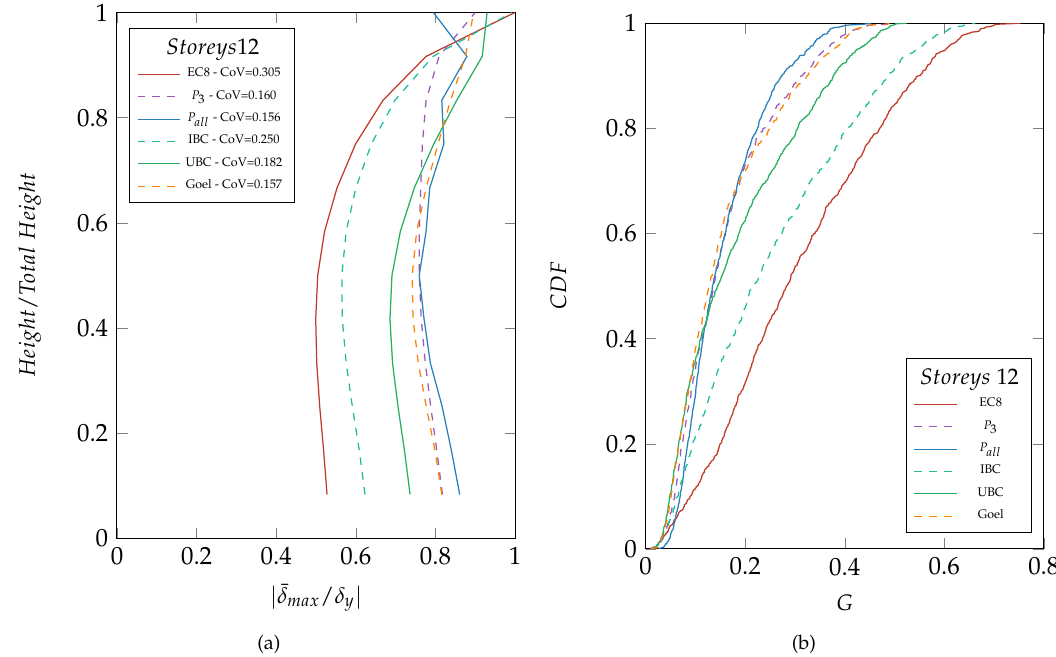
Figure 5. Mean maximum dimensionless inter-storey displacement distribution of the 12-storey SBM designed according to the load patterns ( a ) and CDF of the variance of the deflected shapes ( b ). Additionally, panel Figure 5b shows the cumulative distribution function (CDF) for the random variable G , whose elements g are defined for each deflected shape by means